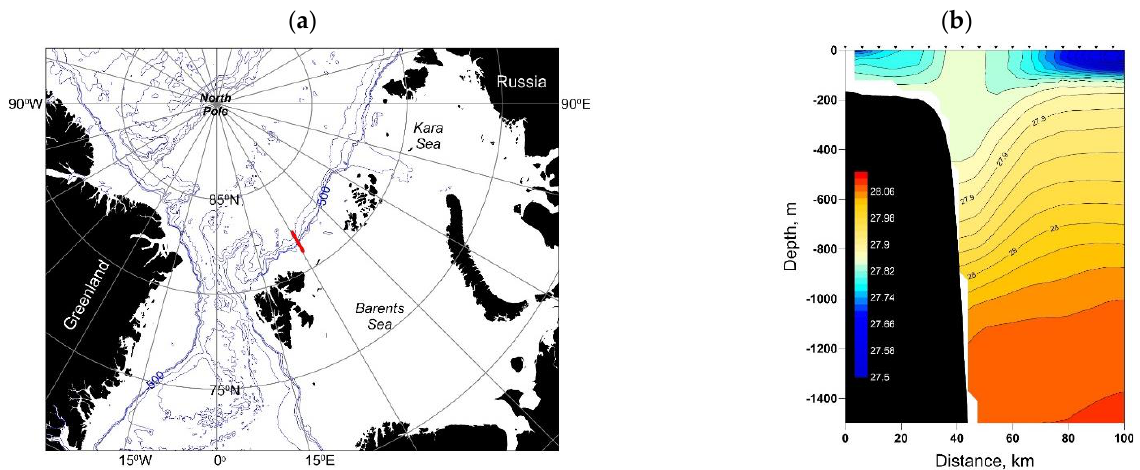
Figure 4. ( a ) Bathymetry map of the Arctic Ocean (blue lines). Location of cross-front section (red); ( b ) vertical distribution of the anomaly of potential density, kg/m 3 (color), on 31 December 2016. Black triangles on the top show location of grid points (based on the data from GLORYS12V1 reanalysis (https://doi.org/10.48670/moi-00021 (accessed on February, 16, 2023).